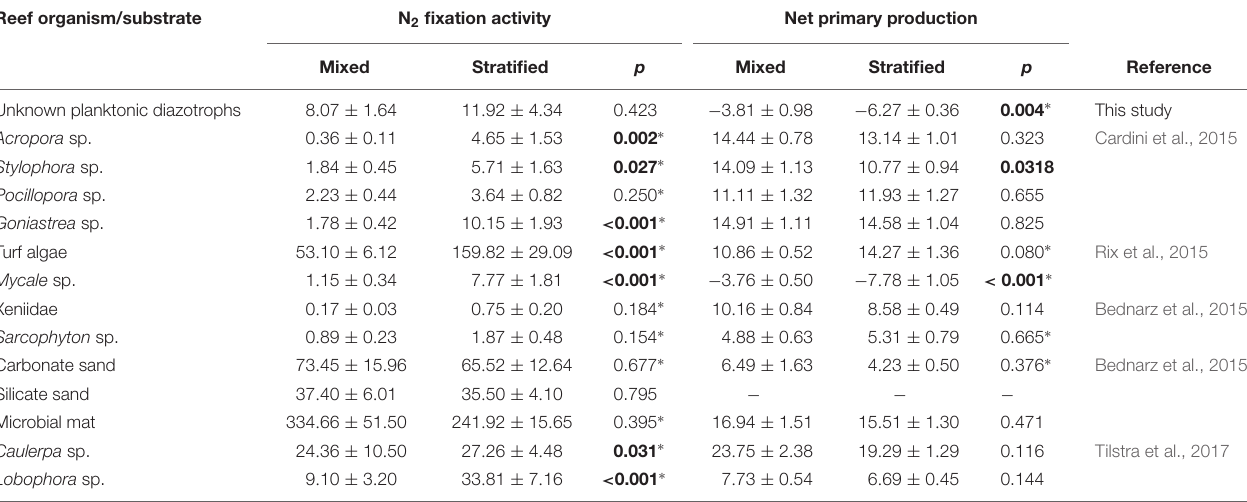
TABLE 6 | Comparison of N 2 fixation and net primary production associated with different coral reef organisms and substrates from the Gulf of Aqaba. Reef